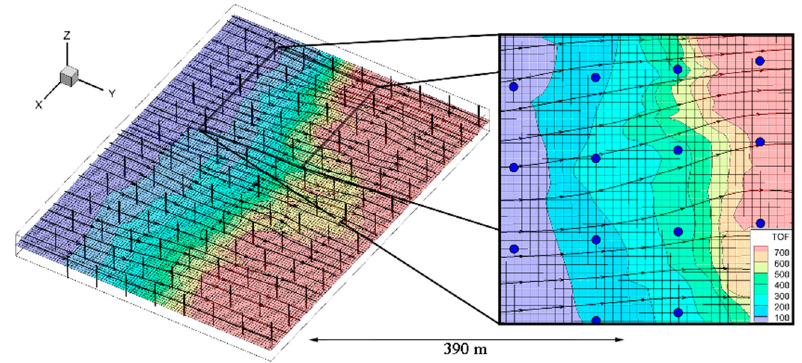
Figure 6. Calculated streamlines and value of TOF throughout the domain.